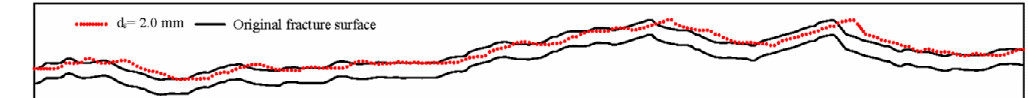
Figure 2. Two-dimensional fracture simulating shear process.